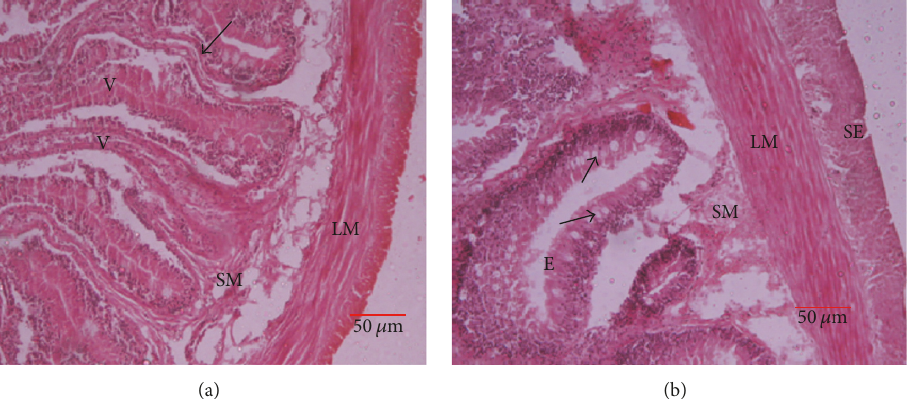
Figure 9: Intestine: E, epithelium, SM, submucosa, V, villi, SE, serosa, and LM, longitudinal muscle; arrows are goblet